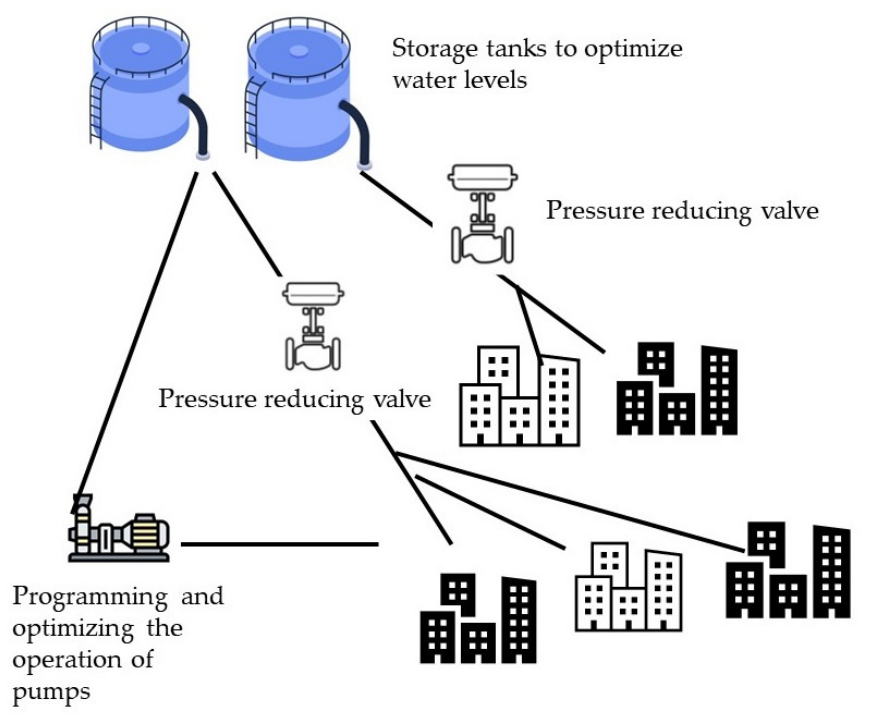
Figure 2. Principals pressure management methods in water distribution networks to reduce leak- age.